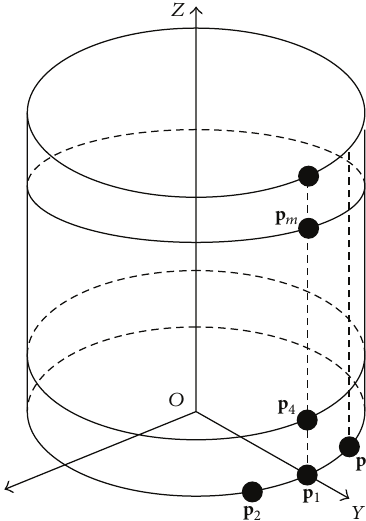
Figure 2: The structure of the cylindrical conformal